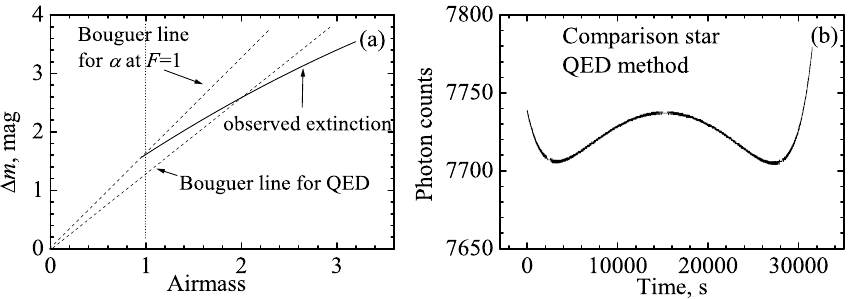
Fig. 2. Illustration explaining the wavy structure of the light curve after the linear extinction correction with the QED program: (a) the de- pendence of extinction on air mass; (b) observations transformed by the standard QED extinction correction